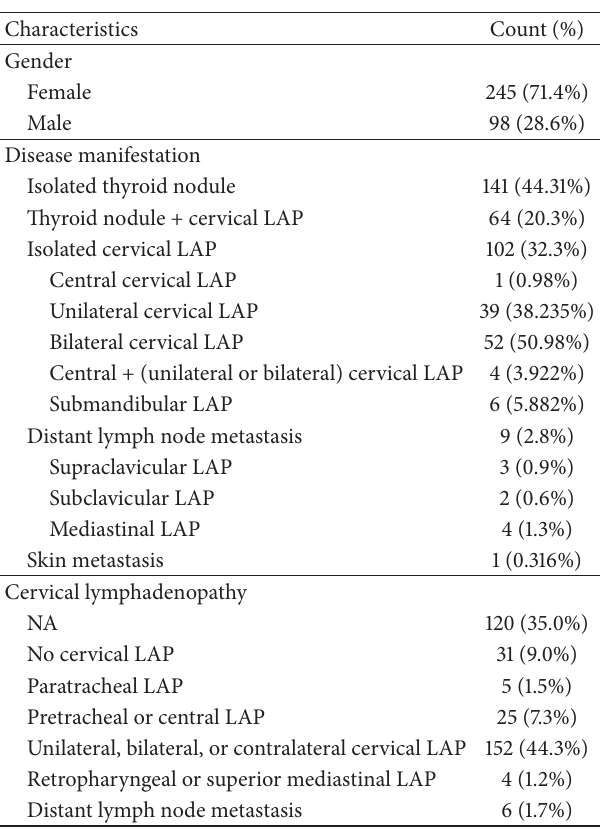
Table 1: Demographic and clinicopathological